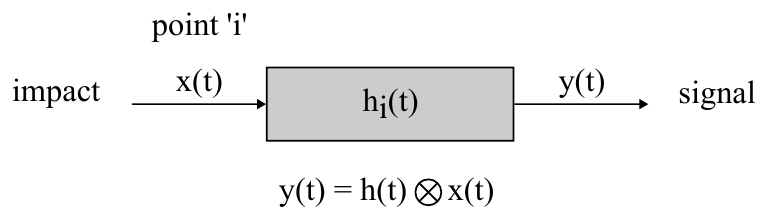
Figure 7. Signal propagation from the point i.